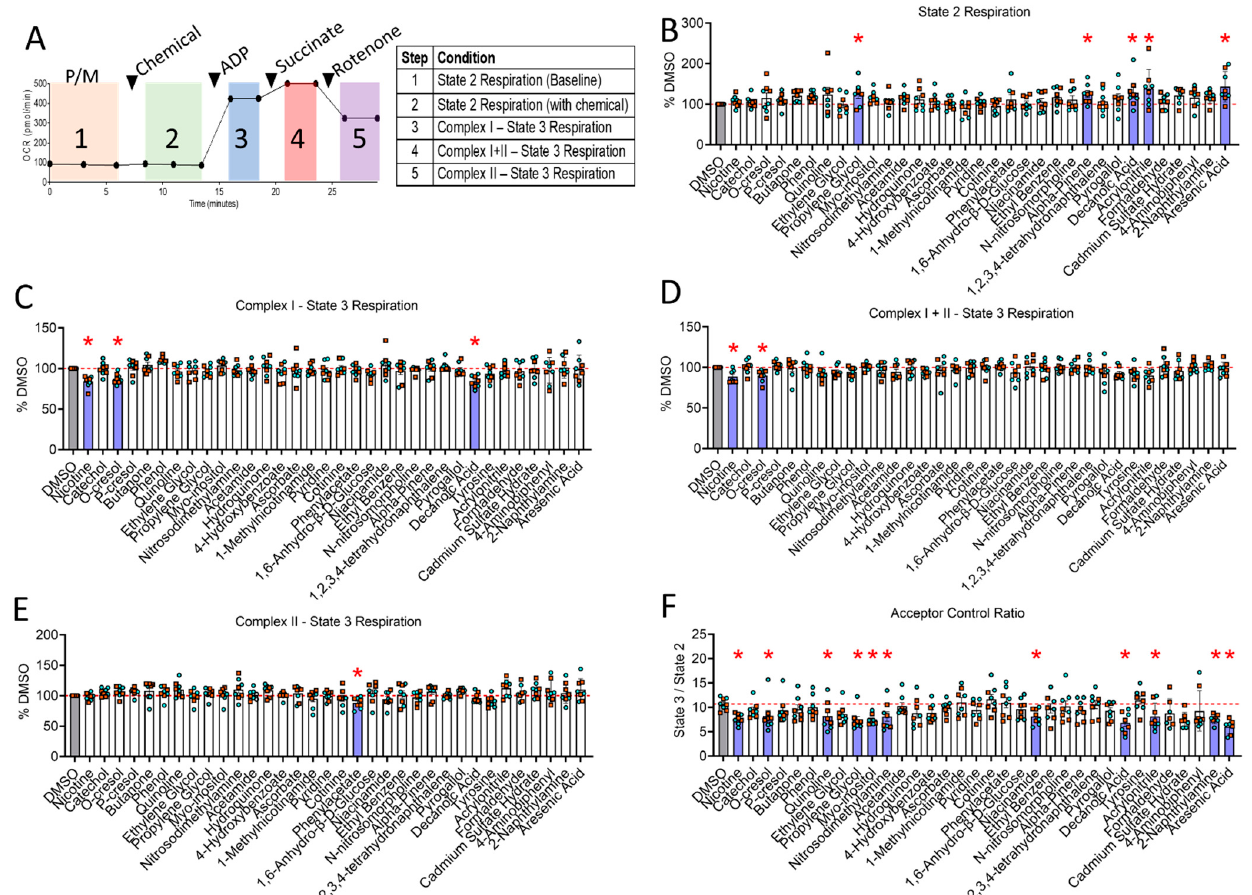
Figure 4. ( A ) Graphical representation for OCR levels given by mitochondrial respiration function parameters (y-axis) versus time (in min, x-axis) is shown with each sequential substrate/inhibitor addition. ( B ) State 2 respiration with mitochondria was energized with pyruvate/malate in the absence of exogenous ADP. ( C ) Quantification for maximal State 3 (ADP stimulated) respiration through mitochondrial Complex I (pyruvate/malate + ADP). ( D ) Quantification for maximal State 3 (ADP stimulated) respiration through mitochondrial Complex I + II (pyruvate/malate/succinate + ADP) ( E ) Quantification for maximal State 3 (ADP stimulated) respiration through mitochondrial Complex II only after inhibition of Complex I with rotenone, respectively. ( F ) The acceptor control ratio (ACR) calculated by dividing State 3 by State 2 respiration supported by Complex I. N = 4 animals per sex. Teal symbols represent male mice; orange symbols represent female mice. * p < 0.05 vs. DMSO using one-way ANOVA and FDR-correction for multiple comparisons. Abbreviations: P/M: pyruvate/malate; ADP: adenosine diphosphate; OCR: oxygen consumption rate; P/M: pyruvate/malate; DMSO: dimethyl sulfoxide; ADP: adenosine diphosphate.